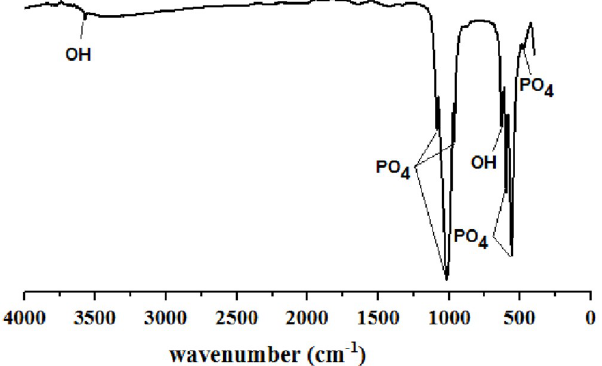
Fig 19. FTIR spectrum of HAp powder at optimal conditions (time = 10 h, pH = 10, temperature = 130˚C).